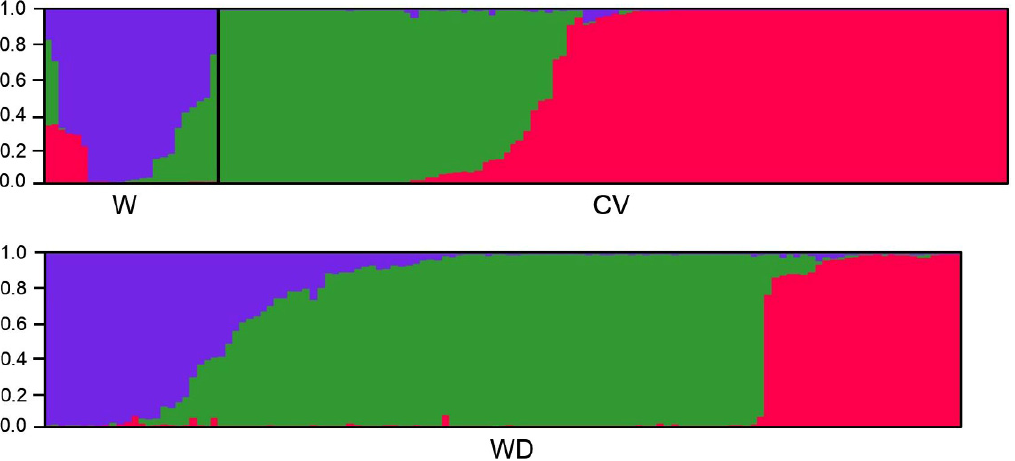
Figure 7. Genetic structure of wild (W), cultivated (CV), and weedy rice (WD) samples based on polymorphisms of the SSR (simple sequence repeat) fingerprints. The key genetic components of wild rice (blue), cultivated rice (green and red), and weedy rice (blue, green, and red) are identified. Each sample is represented by a single vertical line (bar) assigned into the three colored segments (genetic components), with lengths proportional to each of the three inferred clusters. Numbers at the vertical axis represent the probability of assignment.